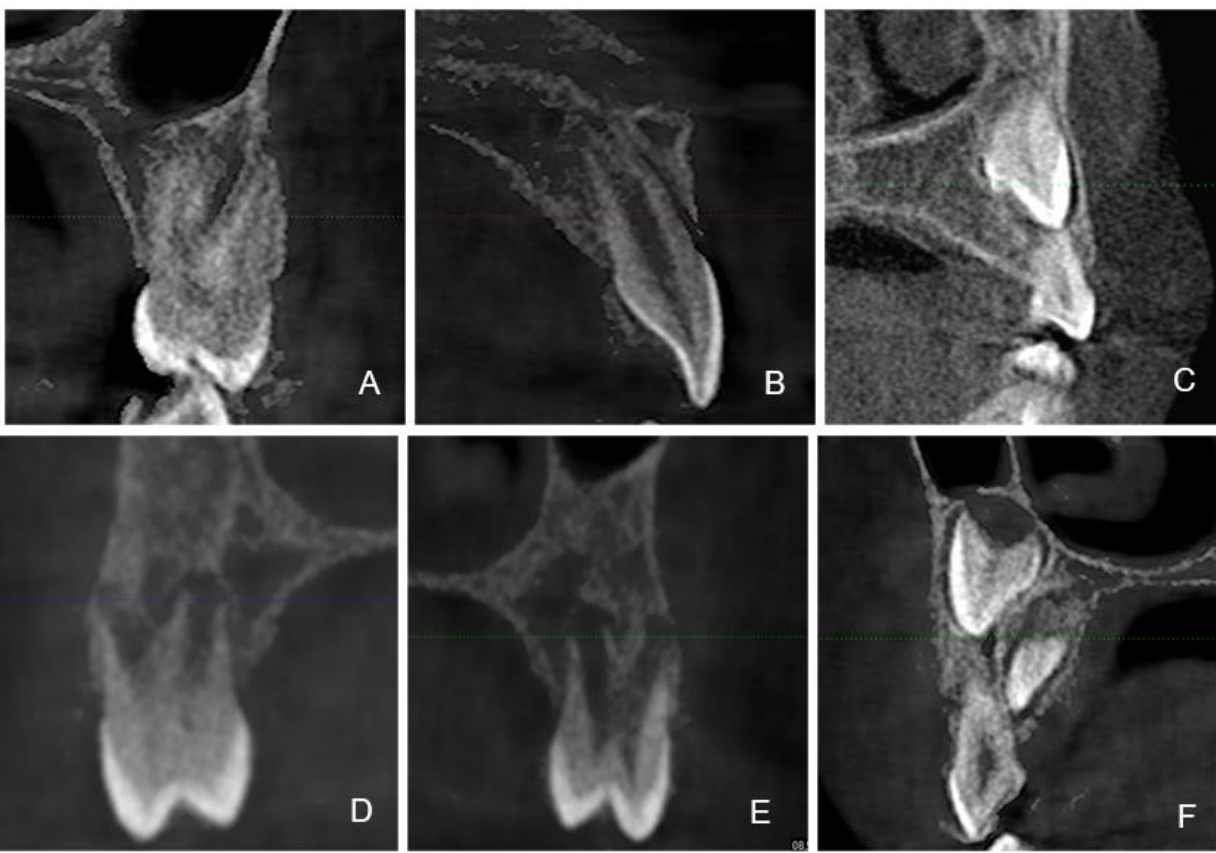
Figure 1. Fenestrations based on the classification by Pan et al. A-Type I; B-Type II; C-Type III; D-Type IV; E-Type V; F-Type